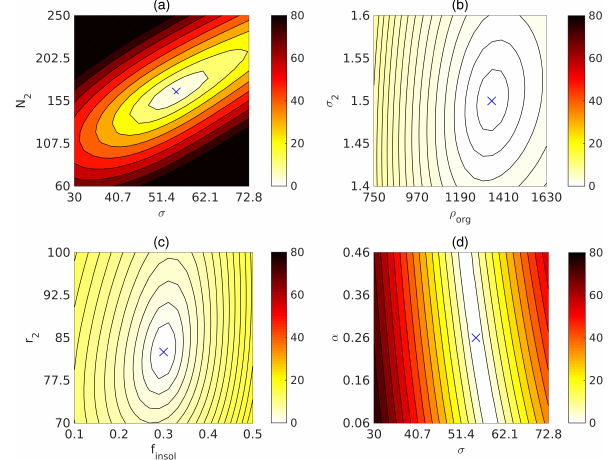
Figure 7. Response surfaces for a np w σ f in the marine average en- vironment. Blue crosses indicate the true parameter values θ true used to calculate the calibration data. The colour scale represents the value of the OF calculated for the modelled spectra against the calibration data for parameter values across the uncertainty ranges (Table 2).